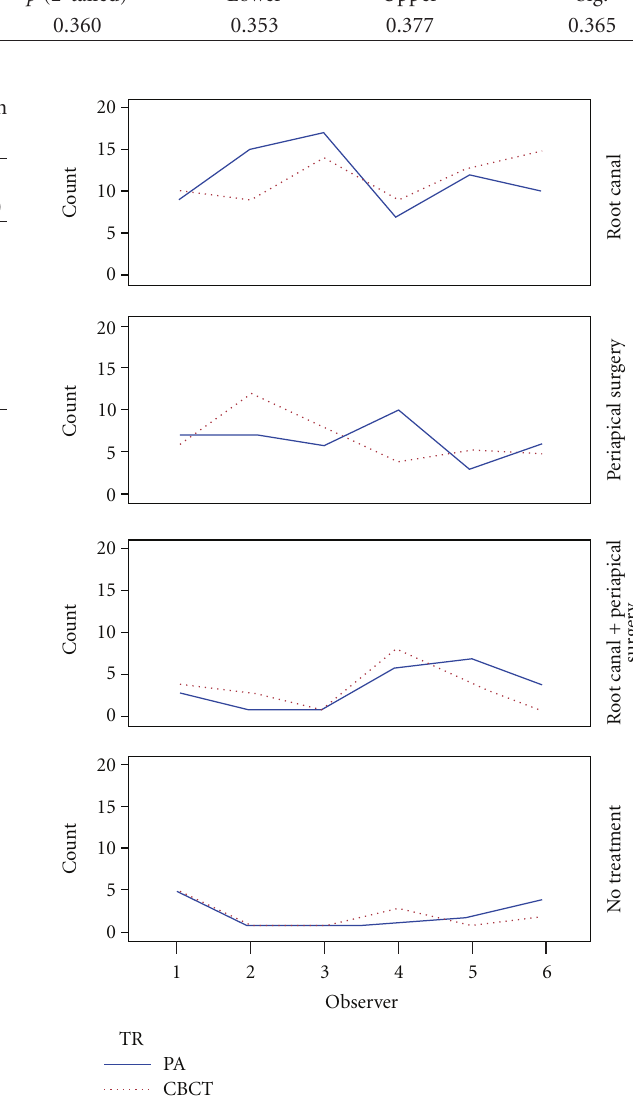
Monte Carlo Sig. (2-tailed)